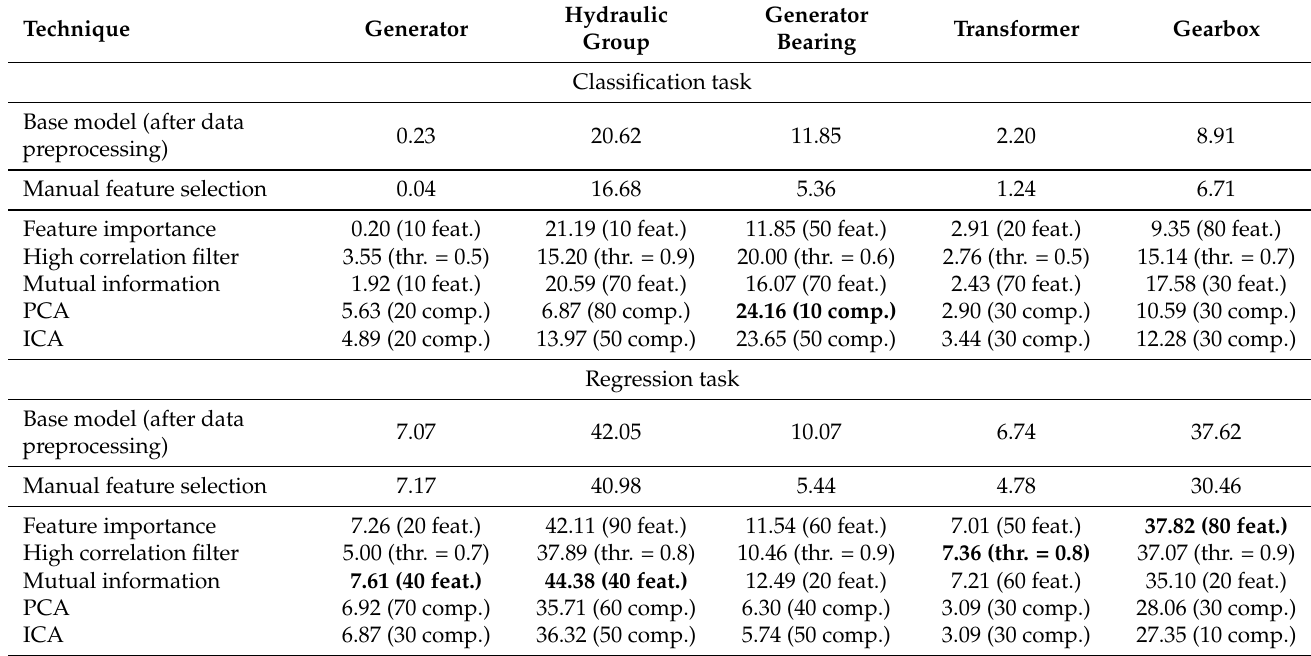
Table 4. Values of F1 score on validation set for the best settings of considered feature selection techniques. Values are presented in